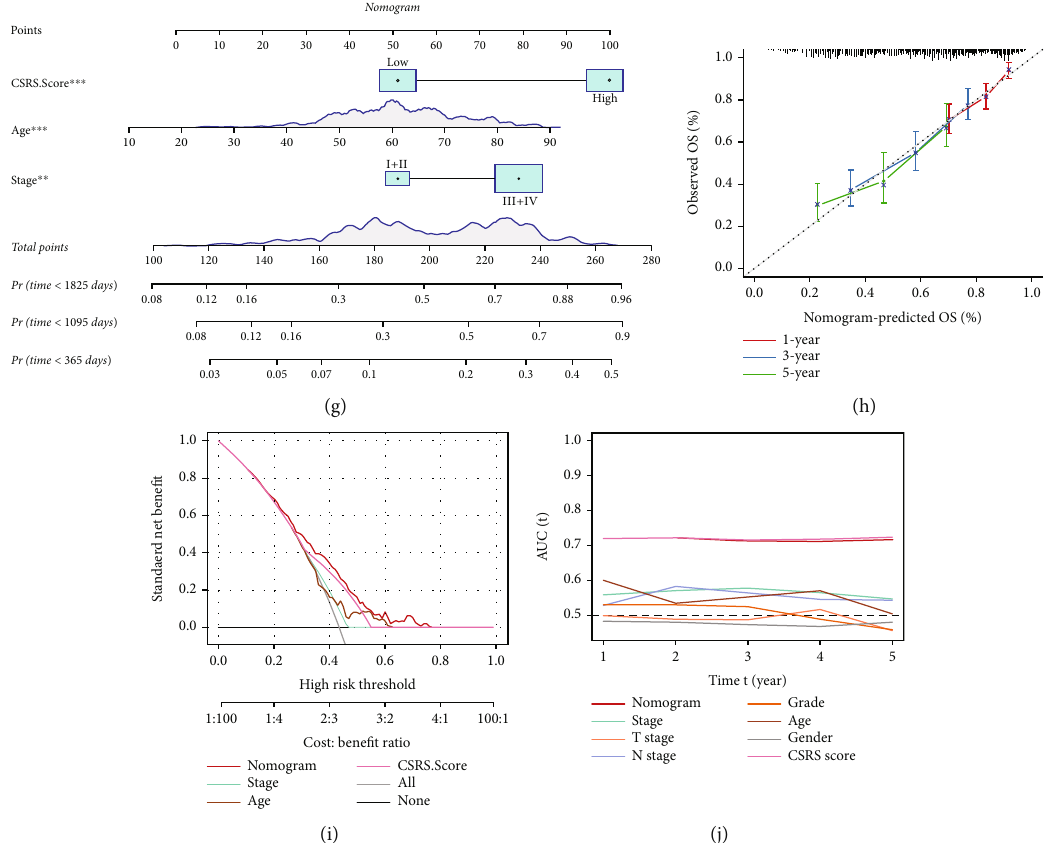
Figure 7: CSRS.Score combined with clinicopathological characteristics to further improve prognostic models and survival prediction. (a) Full-scale annotations of patients including gender, CSRS.Score, age, grade, and TNM stage were applied to develop a survival decision tree for optimizing the risk strati fi cation. (b) Among the four subgroups, signi fi cant di ff erences in overall survival could be found. (c, d) Comparative analysis between di ff erent subgroups. (e, f) Univariate (e) and multivariate (f) Cox analysis of CSRS.Score and clinicopathological features. (g) A nomogram was developed based on age, CSRS.Score, and stage. (h) Calibration curves for 1, 3, and 5 years for the columnar graph. (i) Decision curve analysis of the nomogram, CSRS.Score, and other clinical features. (j) Compared with other clinicopathological features, the nomogram exhibited the most powerful capacity for survival